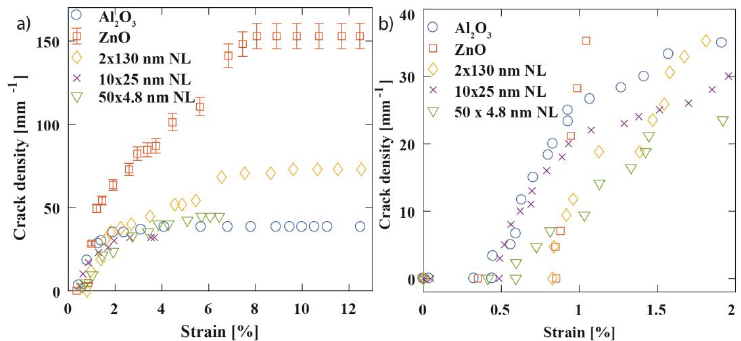
Figure 7. Crack density evolution during tensile tests for a selection of test samples. ( a ) Full strain range from zero to 10%. ( b ) Zoom into the region of fracture onset strain.